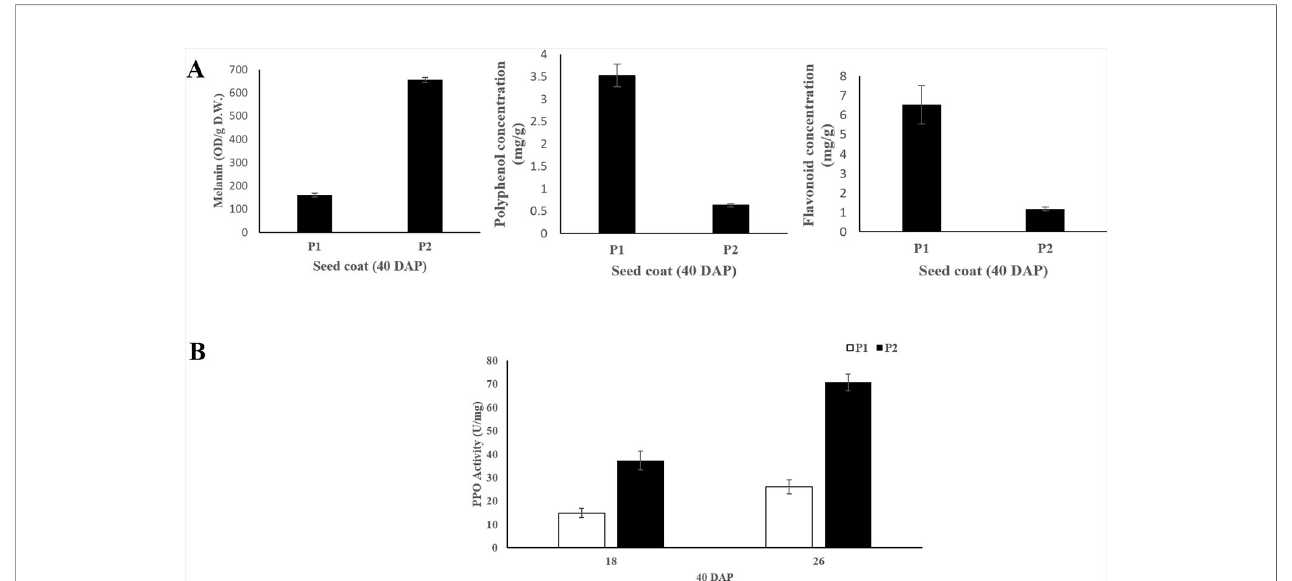
FIGURE 2 | (A) Melanin, polyphenol and fl avonoid content of seed coat at 40 DAP between the two parental lines. (B) PPO activity of the seed coat at 18 and 26 DAP between the two parental lines. Three biological and technical replicates were used for the